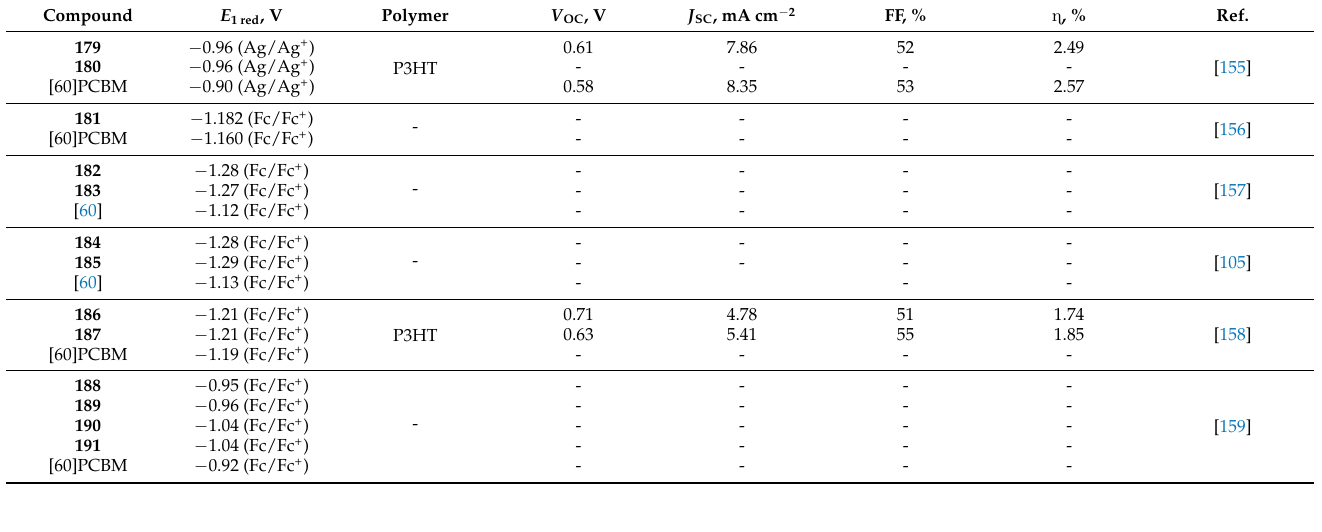
Table 5. First reduction potentials and characteristics of the solar cells based on the fullerene cy- cloadducts.